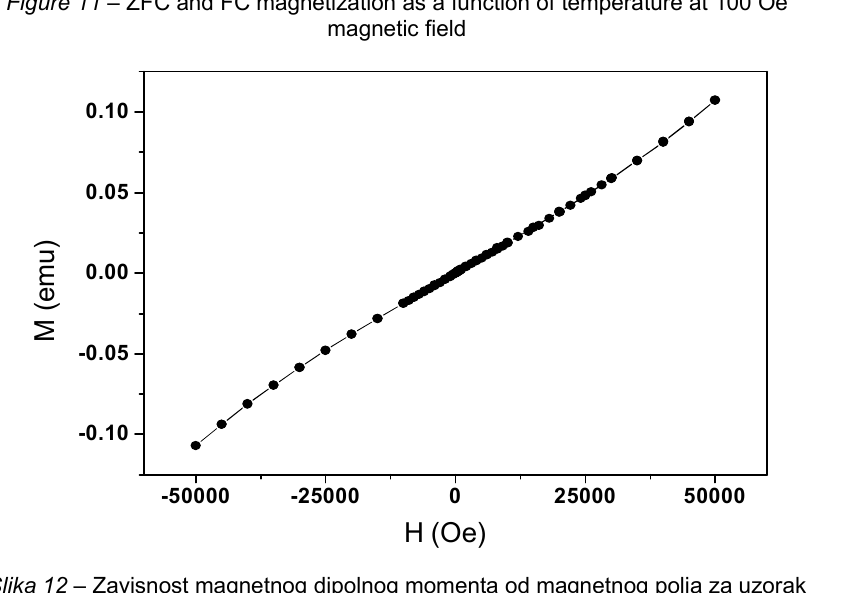
Figure 12 – Magnetic dipole moment dependence of the magnetic field at 100K temperature for high cristallinity